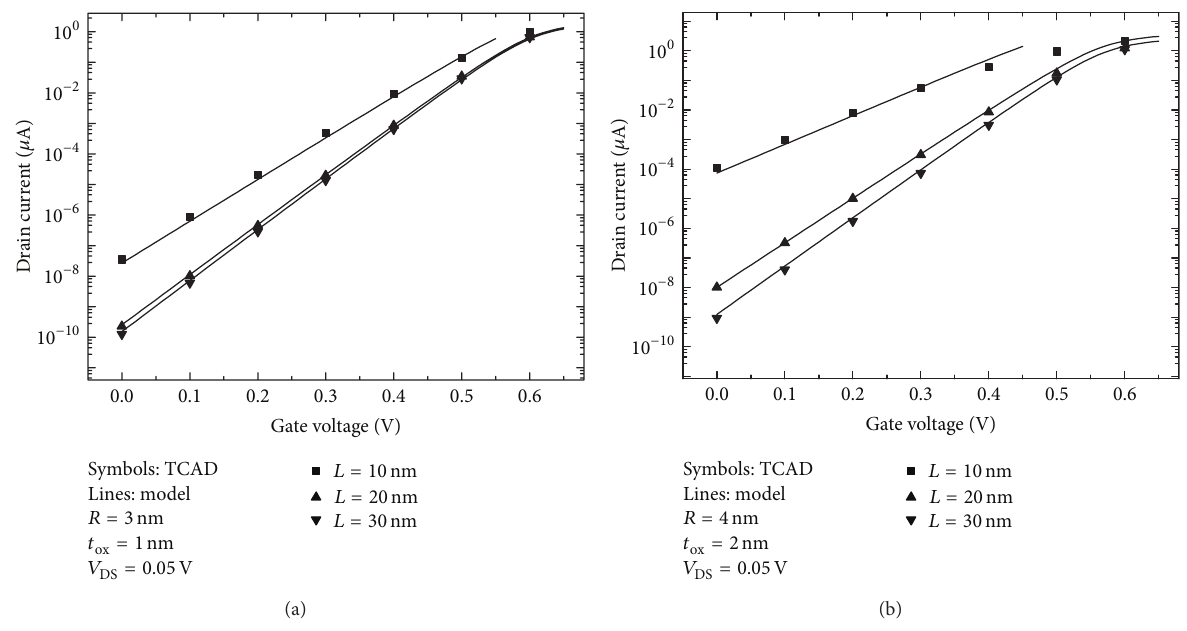
Figure 6: Subthreshold transfer characteristics obtained from the model and TCAD simulation for different gate lengths. Drain bias is 0.05 V. (a) Radius is 3nm; (b) oxide thickness is 2 nm. The other device parameters are obtained from Table